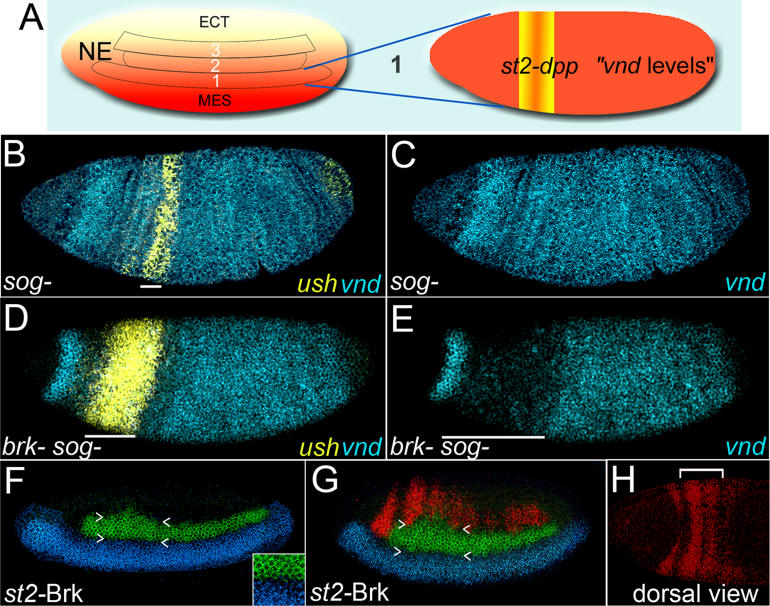
BMP Signaling Can Also Repress Expression of vnd
(A) Scheme for generating ventro-lateralized embryos with a uniform level of Dorsal adjusted to that present in the ventral neuroectoderm (e.g., vnd expressing cells). These embryos were collected from gd
7
sog
U2/gd
7
; Tl
3/+ mothers (B and C) or sog
Y506 brkm68/FM7; Tl
r4/Tl
r4 mothers (D and E).(B and C) ush (yellow) and vnd (cyan) expression in a sog−; st2-dpp ventro-lateralized embryo. Note that while ush expression is induced in response to dpp expression in this embryo (bracket), the pattern of vnd expression remains unaffected.(D and E) ush (yellow) and vnd (cyan) expression in a brk− sog−; st2-dpp ventro-lateralized embryo.(D) The level and width of ush expression (bracket) is greater than in sog− single mutants (compare with [B]).(E) Note the broad domain of reduced vnd expression (bracket), which extends anterior to the st2-dpp expression domain.(F−H) Expression of msh (red), ind (green), and vnd (blue) in a st2-brk embryo that has a normal Dorsal gradient.(F) A mid-blastoderm stage embryo showing shifts in the dorsal and ventral borders of ind expression. The inset shows higher magnification of the ind/vnd border in the region of st2-brk expression, which is consistently shifted dorsally by 1−2 cells within the stripe of brk expression. This shift is most clearly revealed by a consistent flattening of what is normally a continuous arc in the ind/vnd border at the position of st2-brk expression. The inset also shows that vnd expression extends up to the ind border and that there is no gap between these gene expression domains. We quantitated the shift in the ind/vnd border in nine st2-brk and nine wild-type embryos by counting the number of ind negative cells above a line spanning the ventral border of ind expression in the head and abdomen comprising a zone four cells wide centered within the st2 domain (or its approximate corresponding position in wild-type embryos). ind is better than vnd for performing this measurement since the ventral ind border is sharper (i.e., more all-or-none) than the dorsal vnd border. This analysis reveals that in st2-brk embryos there is an average of 5.4 ± 2.65 ind negative (vnd positive) cells above the line (which corresponds to an average shift of the ind/vnd border of 5.4/4 = 1.35 cells dorsally). In contrast, for control wild-type embryos we counted an average of 0.44 ± 0.88 cells above the line corresponding to an average of 0.11 cells. This represents a 10-fold difference between wild-type and st2-brk embryos, which is highly significant in a students' t-test (p < 0.0003).(G) Lateral view of a slightly older embryo than that shown in (F) showing a significant dorsal shift of the msh/ind border and a smaller shift of the ind/vnd border. The carets in (F and G) indicate the approximate trajectories of the ind/vnd and msh/ind borders in wild-type embryos.(H) Dorsal view of the same embryo shown in (G) revealing that msh expression expands to the dorsal midline.